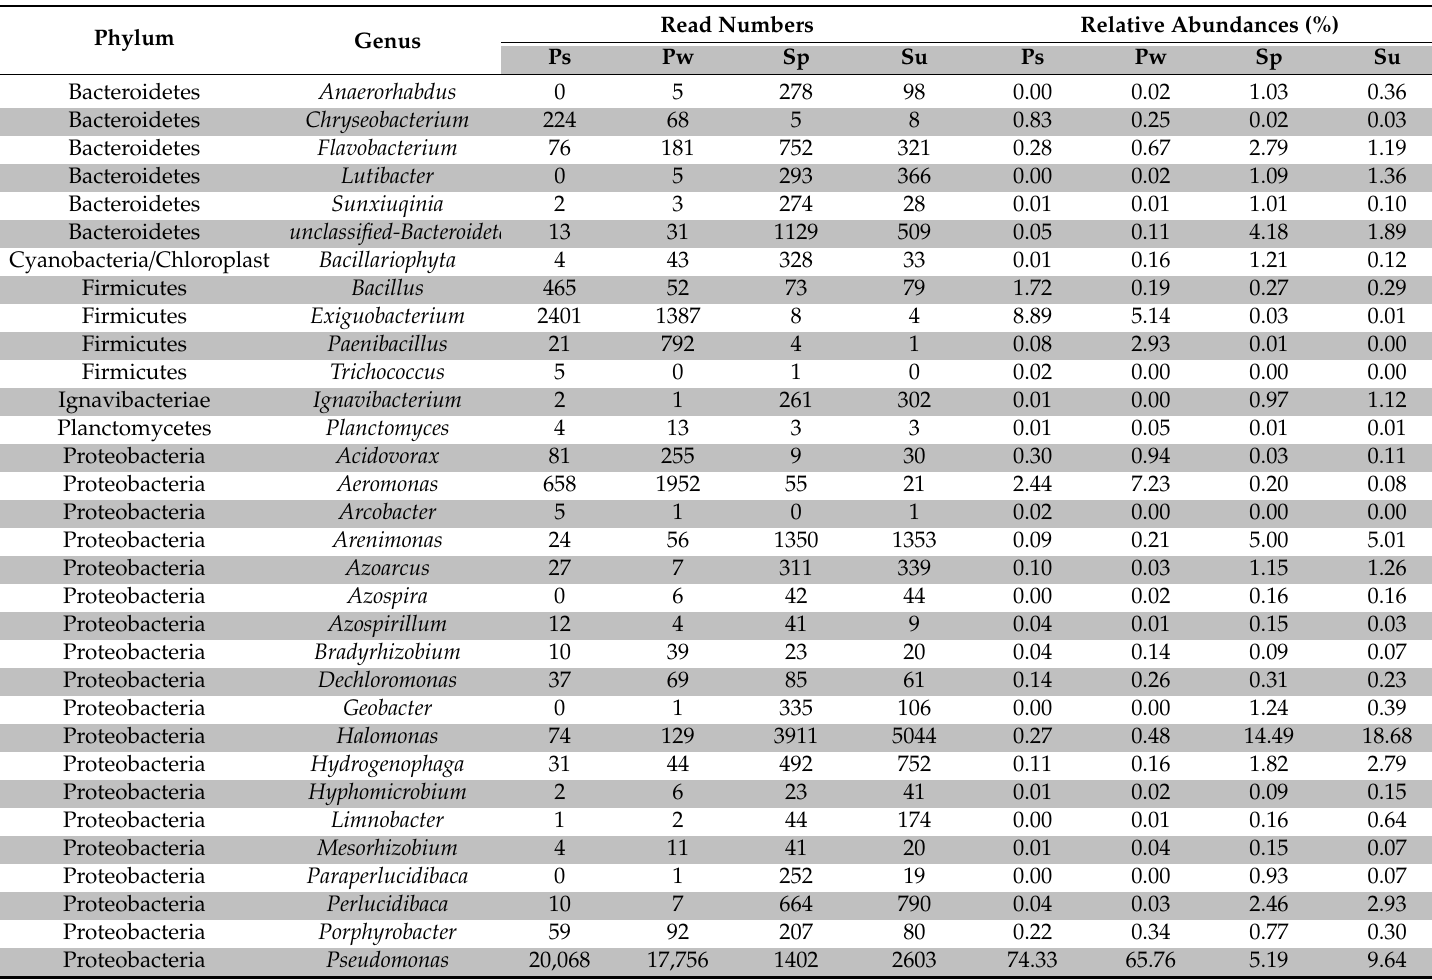
Table A4. The main genera (relative abundance > 1.00%) with the addition of two nitrifying bacteria ( Nitrospira and unclassified-Nitrosomonadaceae ) in the samples from rhizoplane or